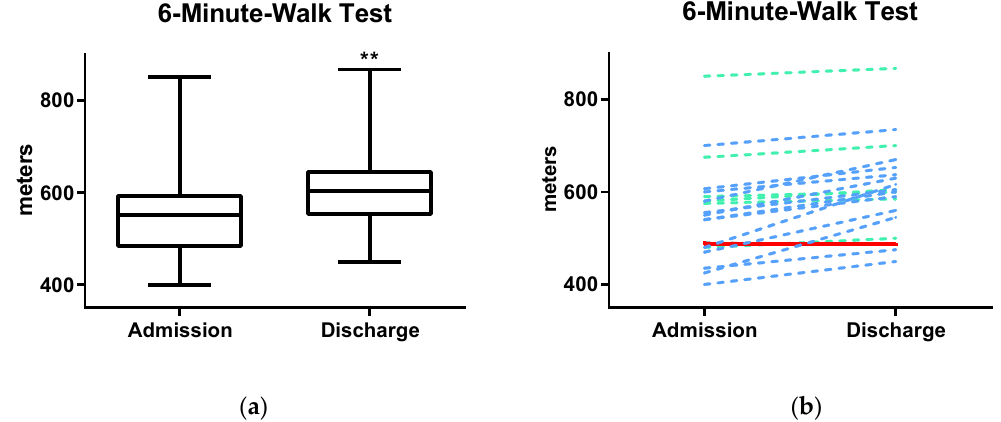
Figure 1. ( a ) Improvements in 6MWT (6-min walk test) at completion of pulmonary rehabilitation. 6MWT improved significantly after completion of pulmonary rehabilitation. ( b ) Individual patients’ results for 6MWT at admission and discharge are presented on the right. Thirteen patients improved above a minimal clinical important difference of 30.5 m (blue line). Six patients improved but were below the minimal clinical important difference (green line). One patient did not improve (red line); Abb.: 6MWT, 6-min walk test; ** = p < 0.001, paired samples t Table 2. Exercise parameters at admission to and reassessment at completion of pulmonary rehabilitation † .